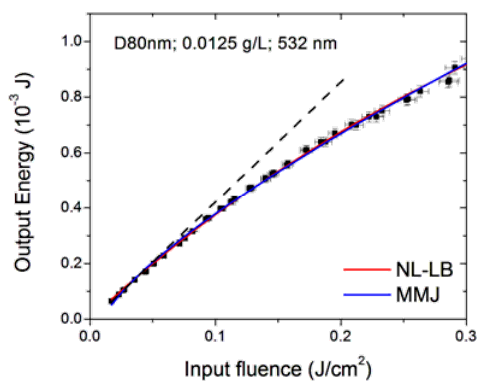
Figure 13. Fit of nonlinear Lambert–Beer (NL ‐ LB) and McEwan–Milsom–James (MMJ) models on the optical limiting curve of theD80nm sample at 532 nm. The dashed black line is a visual reference for the linear regime.